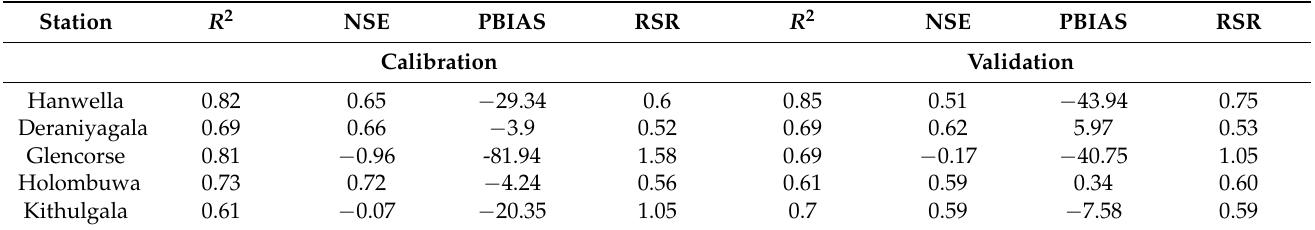
Table 4. Performance evaluations for the monthly discharge simulation (Hanwella